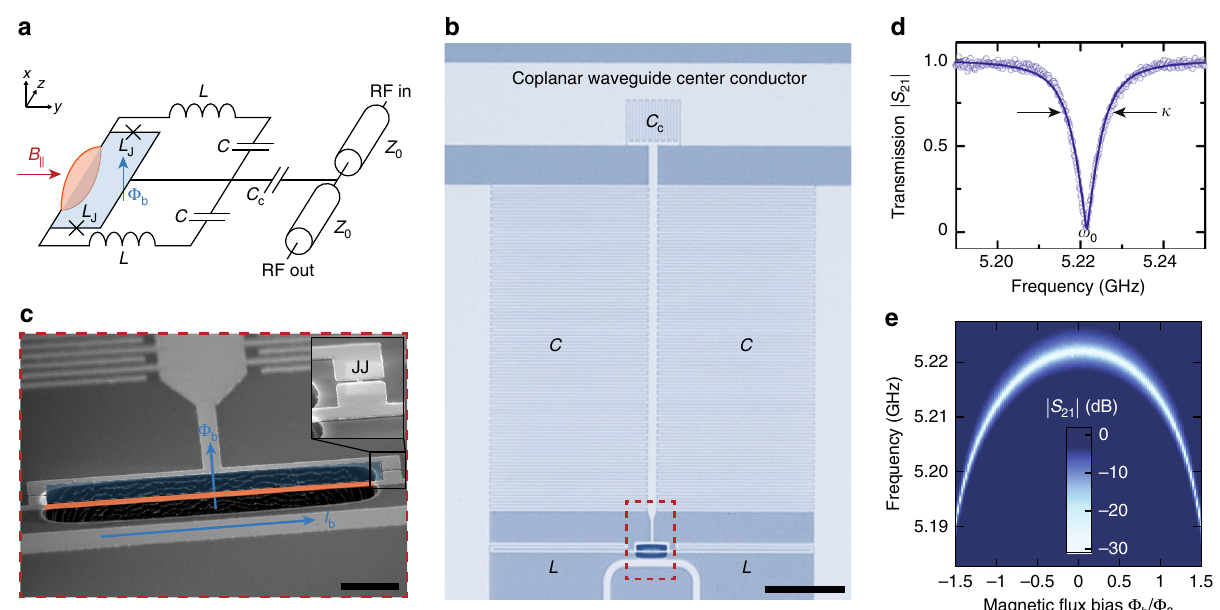
Fig. 1 A superconducting microwave circuit with magnetic- fl ux-mediated optomechanical coupling to a mechanical oscillator. a Circuit schematic of the device. The LC circuit is capacitively coupled to a microwave transmission line with characteristic impedance Z 0 by means of a coupling capacitor C addition to the linear capacitors C and inductors L , a superconducting quantum interference device (SQUID) is built into the circuit, consisting of two Josephson junctions with inductance L in a closed superconducting loop, of which a part is suspended and free to move perpendicular to the circuit plane. J To bias the SQUID with magnetic fl ux Φ , a magnetic fi eld can be applied perpendicular to the circuit plane. Motion of the mechanical element is b transduced into modulations of the bias fl ux by a magnetic in-plane fi eld B jj . An optical micrograph of the circuit is shown in ( b ), light gray parts correspond to a 20nm thick layer of aluminum, dark parts to silicon substrate. The black scale bar corresponds to 50 μ m. The red dashed box shows the region, which is depicted in a tilted scanning electron micrograph in ( c ), showing the SQUID loop with the released aluminum beam. The bias fl ux through the SQUID loop Φ can be changed by a bias current I sent through the on-chip fl ux bias line. The black scale bar corresponds to 3 μ m. The inset shows a zoom into b b one of the constriction type Josephson junctions (JJs). In ( d ) the cavity resonance is shown, measured by sending a microwave tone to the microwave feedline and detecting the transmitted signal S . A fi t to the data points (circles), shown as line, reveals a resonance frequency of ω 21 a linewidth κ ¼ 2 π ´ 10 : 5 MHz. Panel ( e ) shows color-coded the tuning of the cavity resonance absorption dip with magnetic bias fl ux in units of fl